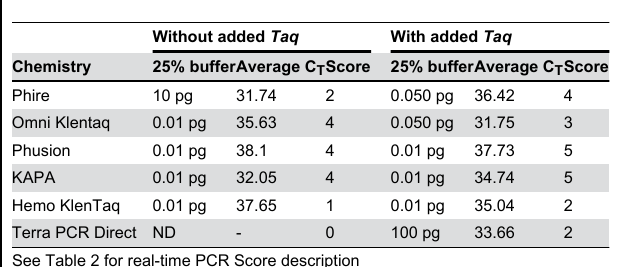
Table 5. Impact of inhibitor-resistant reagents on detection and qualitative real-time PCR